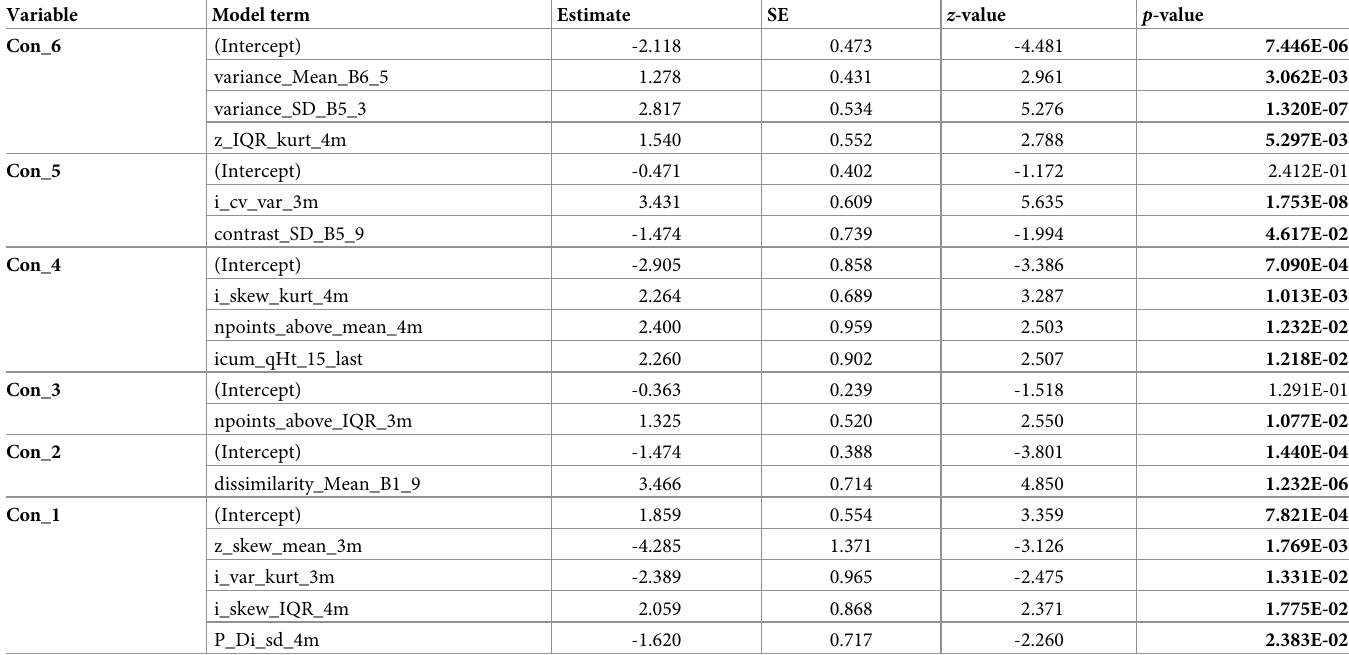
Table 6. Summary of LIDSAT Dirichlet model regression coefficients for each of the six connectivity levels.